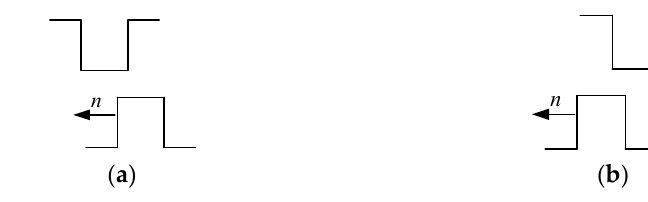
Figure 7. Sliding in ( a ) and out ( b ) processes of the rotor.